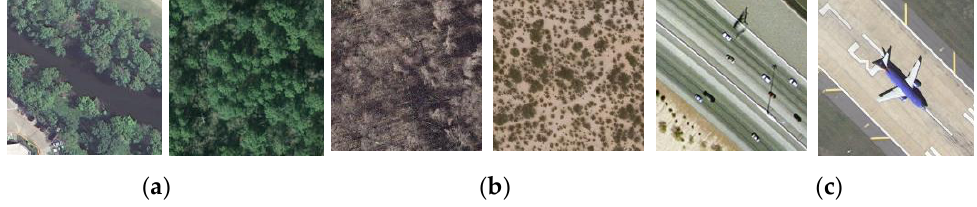
Figure 2. Similar categories that traditional bag-of-words (BOW) may misclassify ( a ) Forest and river ( b ) Forest and chaparral ( c ) Freeway and airport.